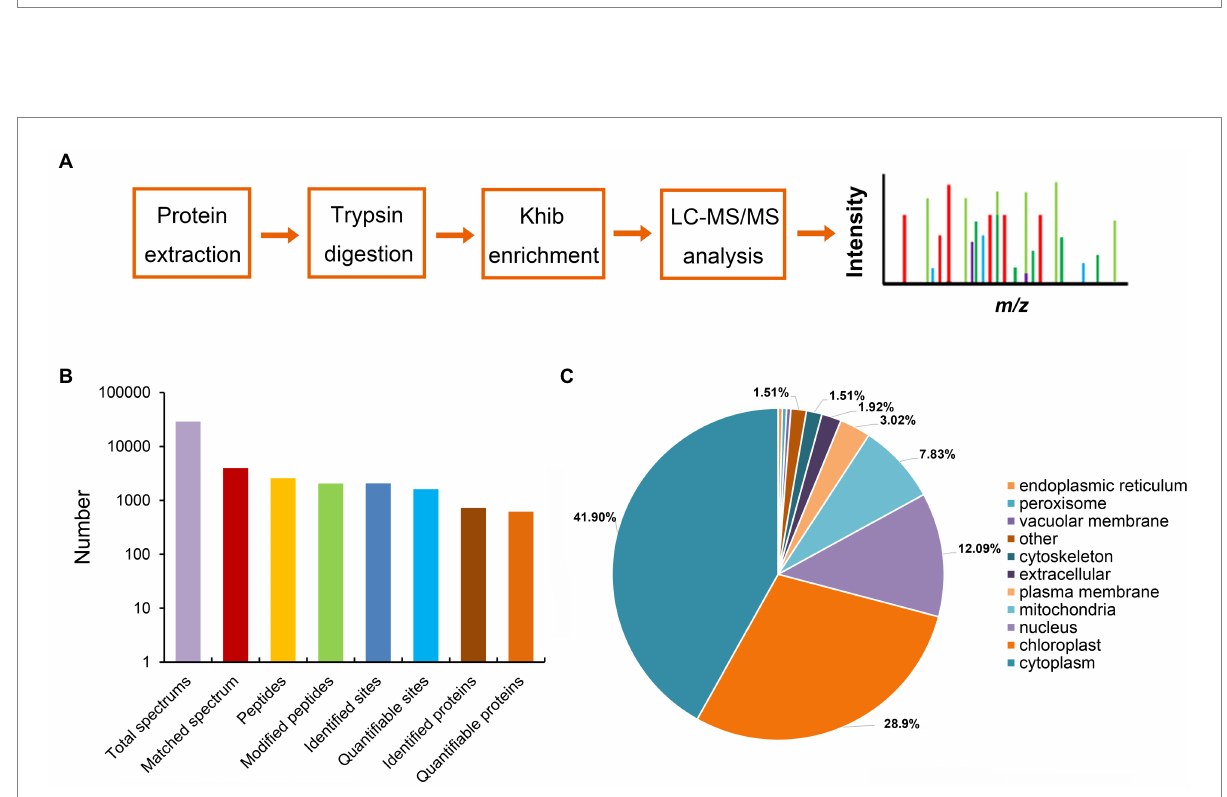
FIGURE 2 Proteome-wide identification and properties of Khib sites in maize. (A) Workflow of proteomics analysis. (B) Statistical analyses of the Khib sites, proteins, and peptides. (C) Subcellular localization of proteins with Khib modifications predicted by WoLF